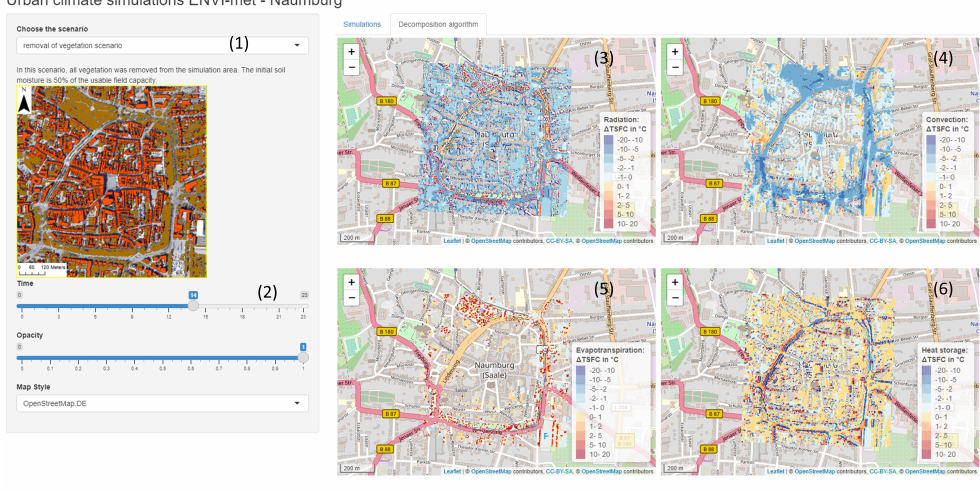
Figure 5. Screenshot of the online visualization tool for the output of the decomposition algorithm: This dashboard consists of a user interface ( left —greyish shaded part) and the corresponding out- put ( right ). The selection options include the simulation scenario (1) and the selection of the time (2). The output consists of spatial representations of the temperature contributions by the surface energy balance components, i.e., radiation (3), convection efficiency (4), evapotranspiration (5) and heat storage (6). This example shows the temperature contributions for scenario 1 (removal of vegeta- tion) at 14:00. The tool is accessible at https://webapp.ufz.de//KlimaKonform//urbansimulation/